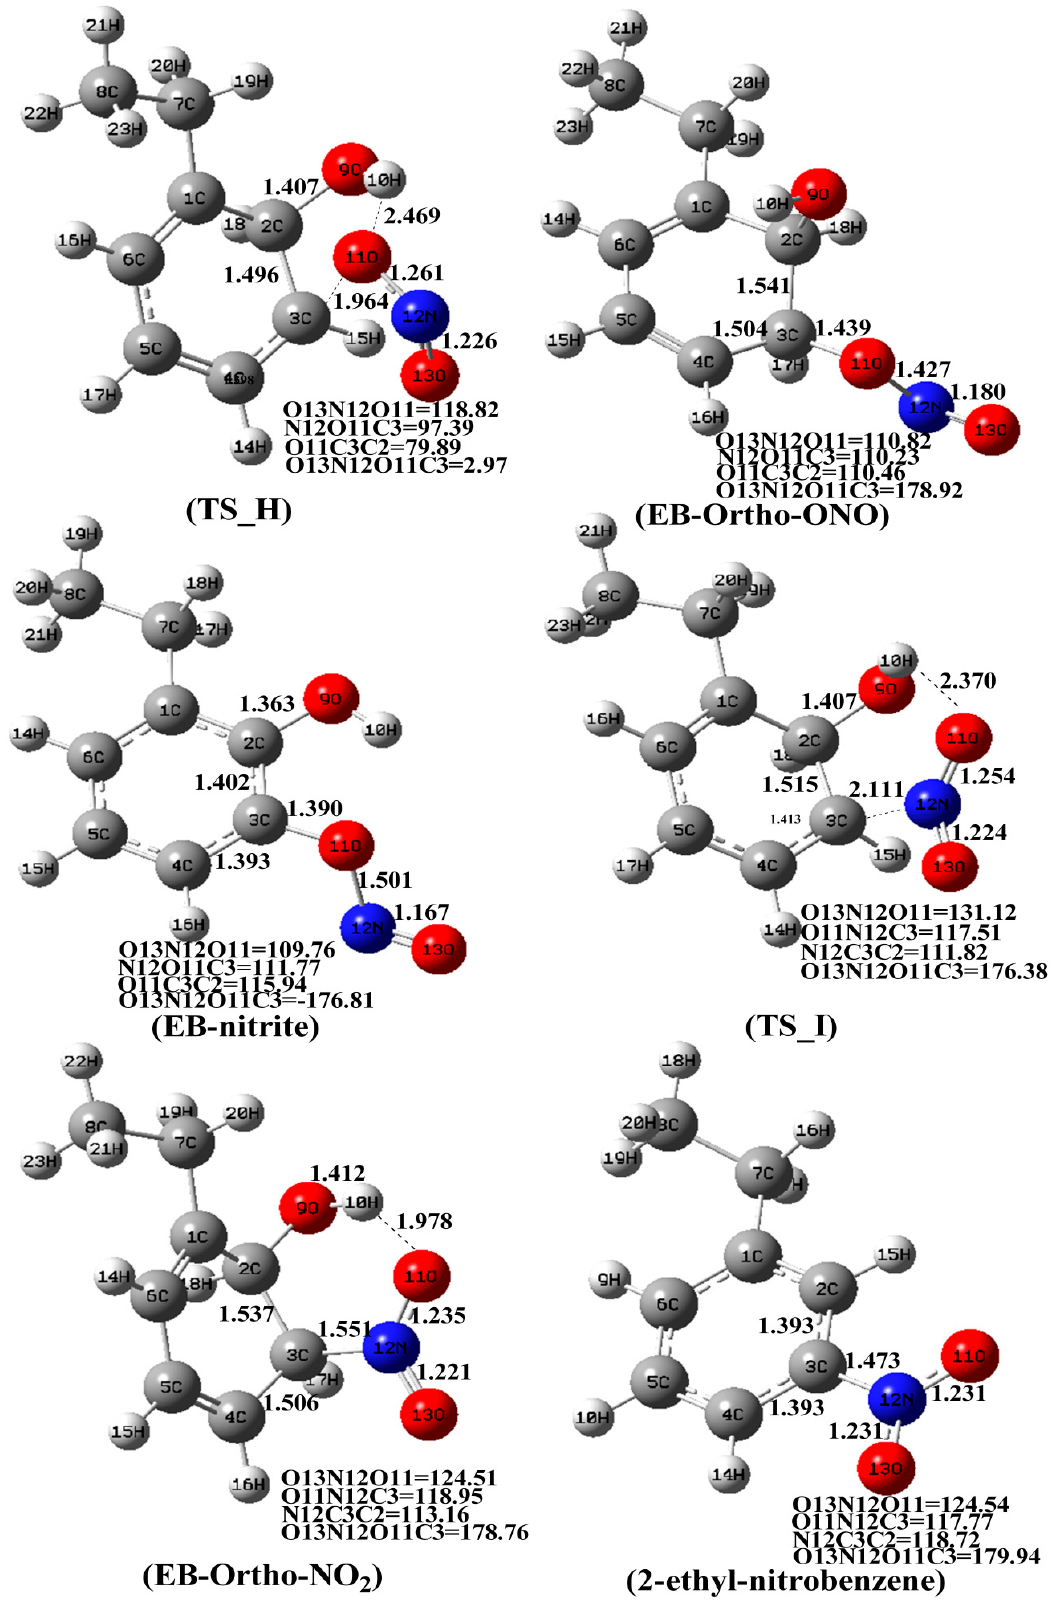
Figure 9. Optimized geometries of various species of Path H and Path I, as shown in Figure 2, at the BHandHLYP/6-311++G (d,p) level (Bond length: Å, Bond angle: °).